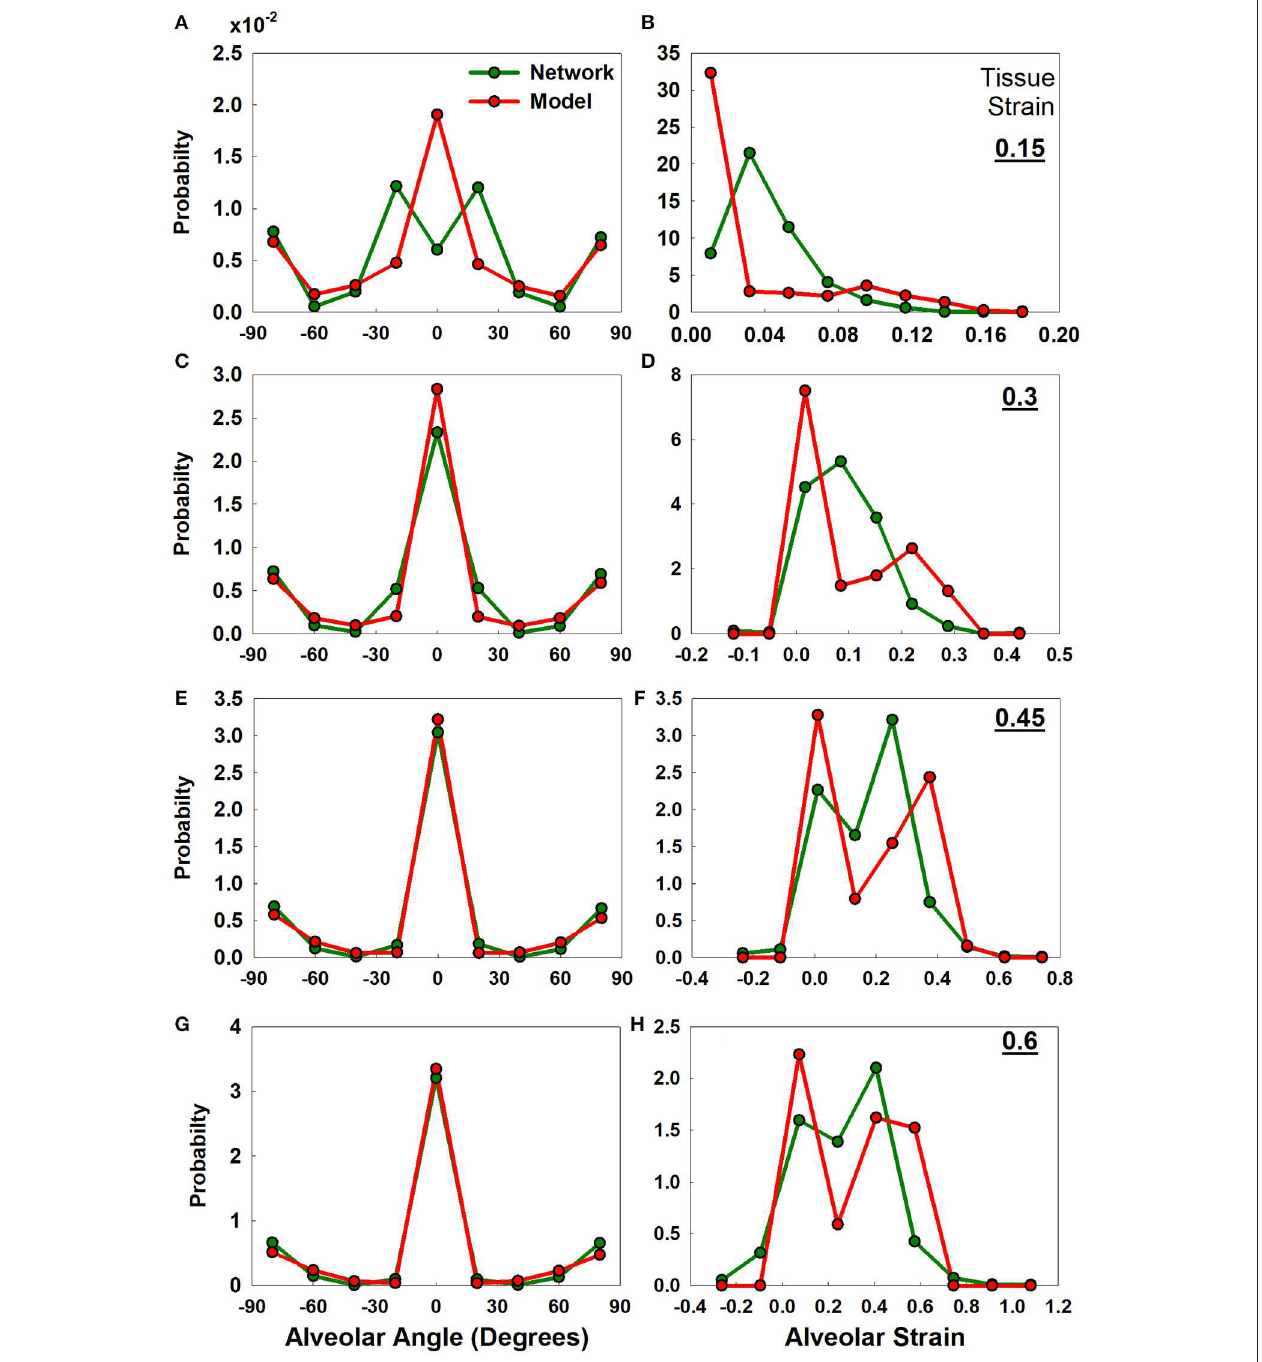
FIGURE 5 | Uniaxial analytical and the network model-based alveolar angle and strain distributions. The graphs show alveolar angle probability distribution functions (A,C,E,G) and alveolar strain probability distribution functions (B,D,F,H) from the analytical model and the network at four levels of tissue strains (0.15, 0.3, 0.45, and 0.6). Initial alveolar strains are zero. Initial angle distribution is shown in Appendix B, Figure 9B